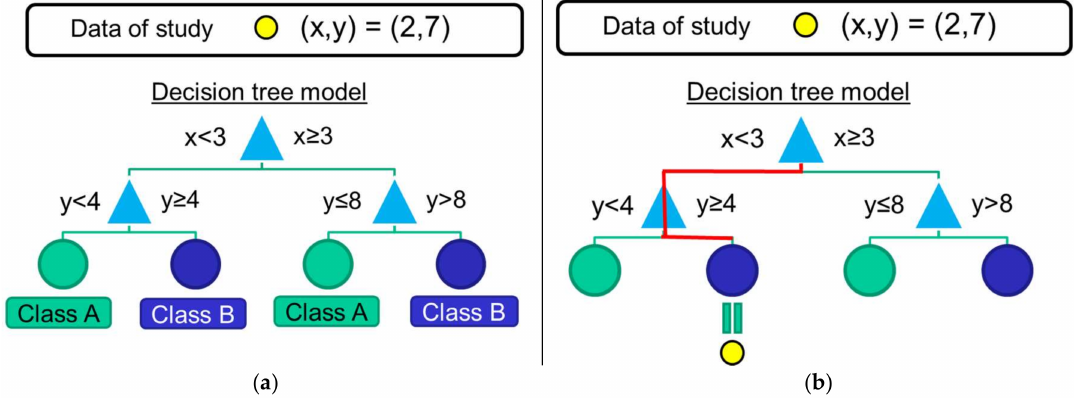
Figure 7. Example of an operation of a decision-tree algorithm: ( a ) after the training phase, the branches and the decision rules the tree are configured; ( b ) during the test phase, the features of an unclassified sample are utilized to apply the decision rules and determine the sample